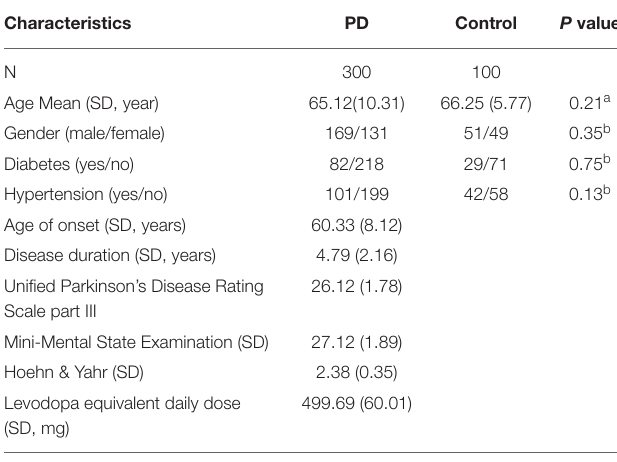
TABLE 1 | Clinicopathological characteristics of healthy control subjects and patients with Parkinon’s disease.